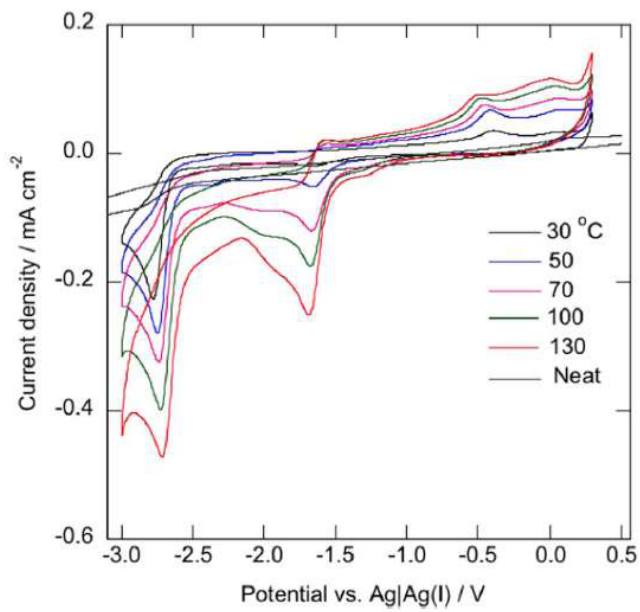
Figure 13. Cyclic voltammograms of a glassy carbon electrode in [N 1116 ][NTf 2 ] containing 5 mM [Pt(acac) 2 ] at various temperatures. Scan rate: 50 mV / s. Reproduced with permission from [61], copyright 2016, RSC.